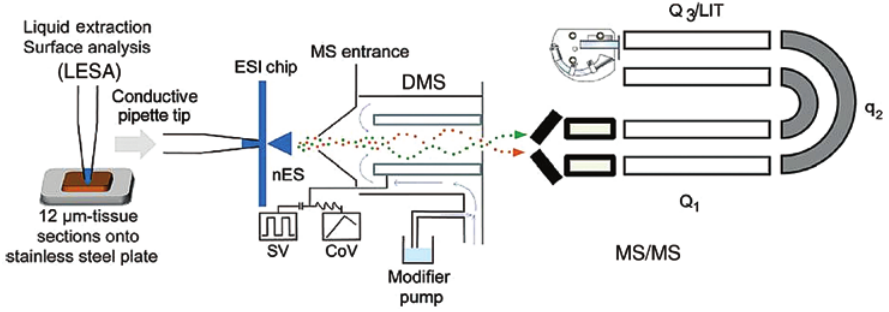
Figure 6: Detection platforms for LESA-DMS-MS/MS